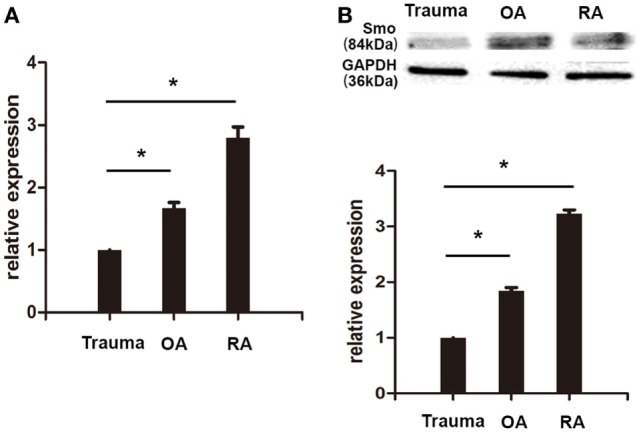
Smo was highly expressed in cultured fibroblast-like synoviocytes (FLSs) from rheumatoid arthritis (RA) patients. RA-FLSs, OA-FLSs, and FLSs from patients with knee traumatic injury were isolated and cultured. The expression of Smo mRNA was detected by real-time PCR. Relative quantification of gene expression was performed by the 2−ΔΔCt method (A). The expression of Smo protein was examined by Western Blot analysis (B). The results represent the mean ± SD of three independent experiments. *P < 0.05 versus control group.